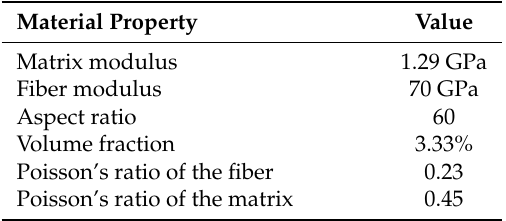
Table 2. Micromechanics input material properties.